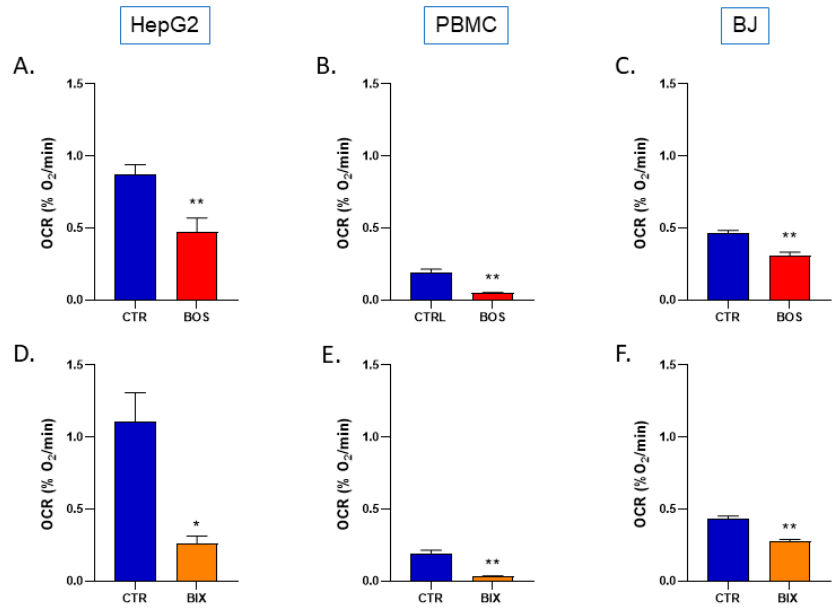
Figure 2. Oxygen consumption rate of control (DMSO 0.1%) and SDHIs-exposed human cells (1 µ M for 2 h). Top row: Boscalid-treated cells. ( A ): HepG2 liver cells, ( B ): PBMCs, ( C ): BJ-fibroblasts. Bottom row: Bixafen-treated cells. ( D ): HepG2 liver cells, ( E ): PBMCs, ( F ): BJ-fibroblasts. Bars represent mean ± SEM (%O 2 /min). N = 3, (*): p < 0.05, (**): p < 0.01.